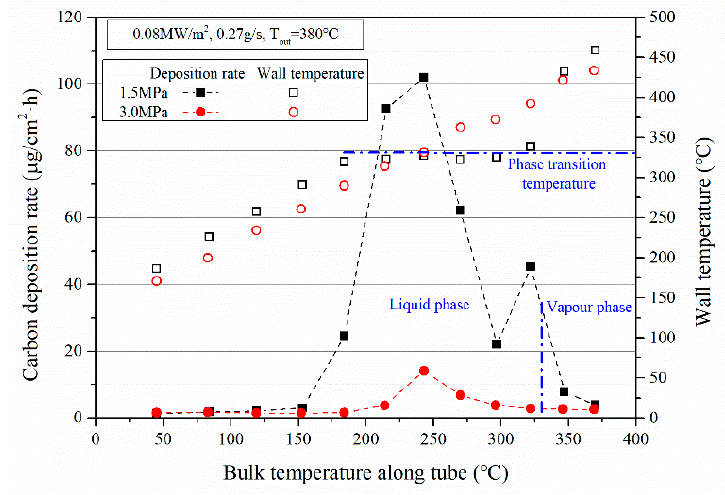
Figure 5. Temperature and deposition rate profiles at subcritical and supercritical pressures.